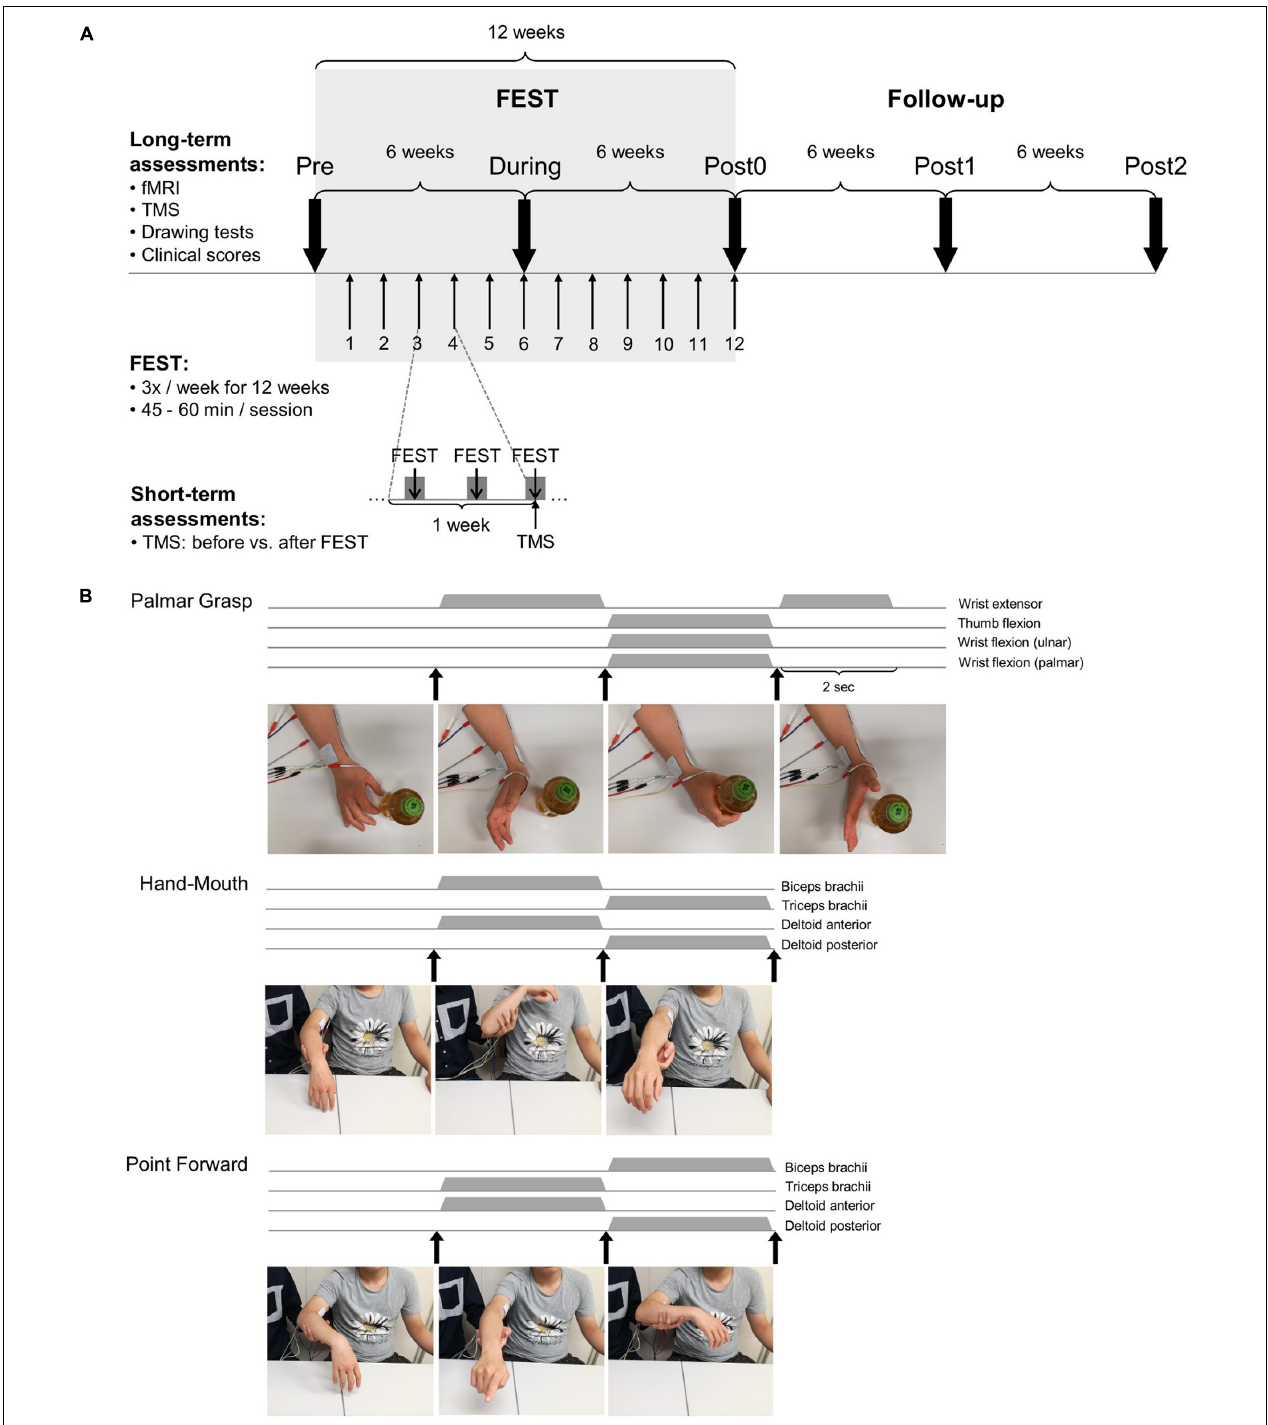
FIGURE 1 | Experimental setup. (A) Experimental protocol – functional electrical stimulation therapy (FEST) was delivered over the course of 12-weeks with three sessions per week and each session lasting 45–60 min. Long-term assessments were carried out at baseline (Pre), after 6- and 12-weeks of FEST (During and Post0), as well as during follow-up 6- and 12-weeks after FEST (Post1 and Post2) and they included: functional magnetic resonance imaging (fMRI), transcranial magnetic stimulation (TMS), drawing tests, and clinical test evaluations. Short-term assessments were carried out once per week over the course of 12-weeks to compare before and after each FEST session using TMS assessments. (B) Each FEST training session consisted of three functional training protocols including the palmar grasp – to generate hand opening, hand-mouth – to generate elbow and shoulder flexion, and point forward – to generate hand pointing forward, by activating a sequence of muscles